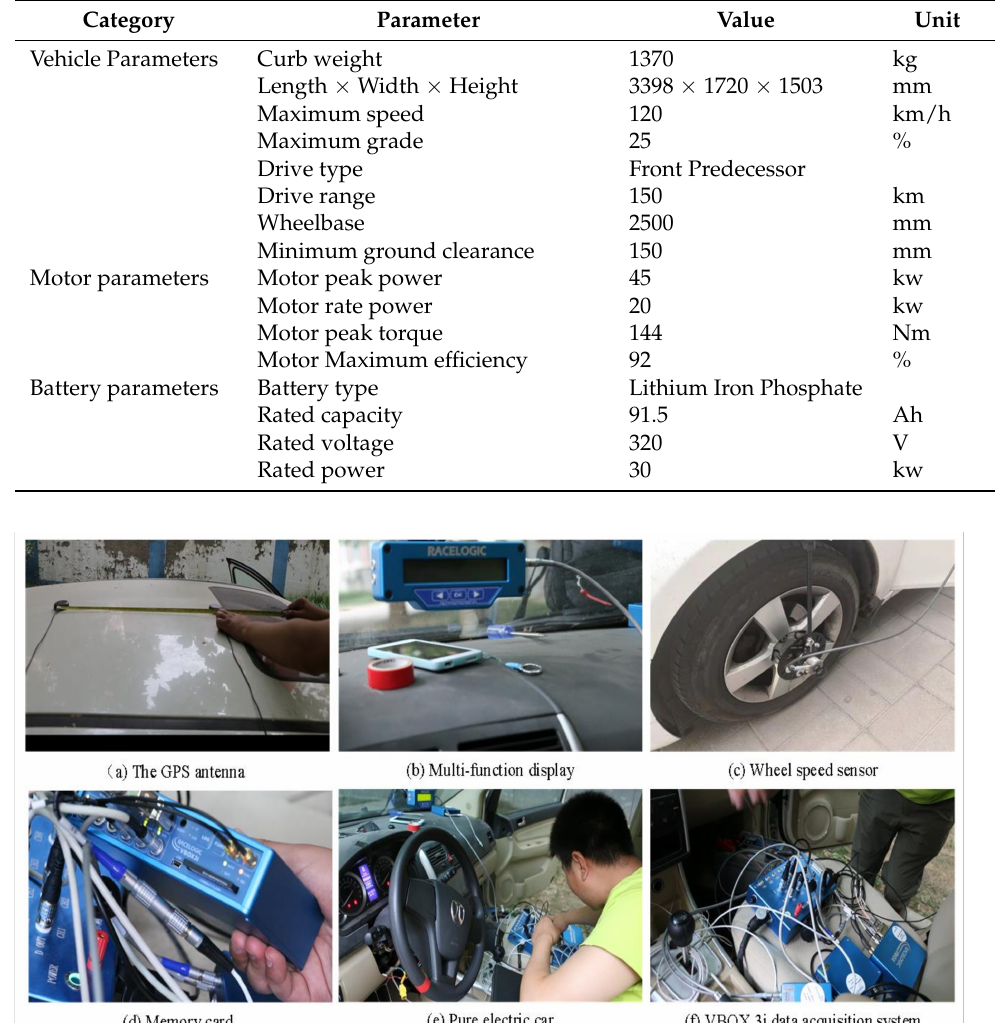
Table 1. Parameters of BJ-EV 150.